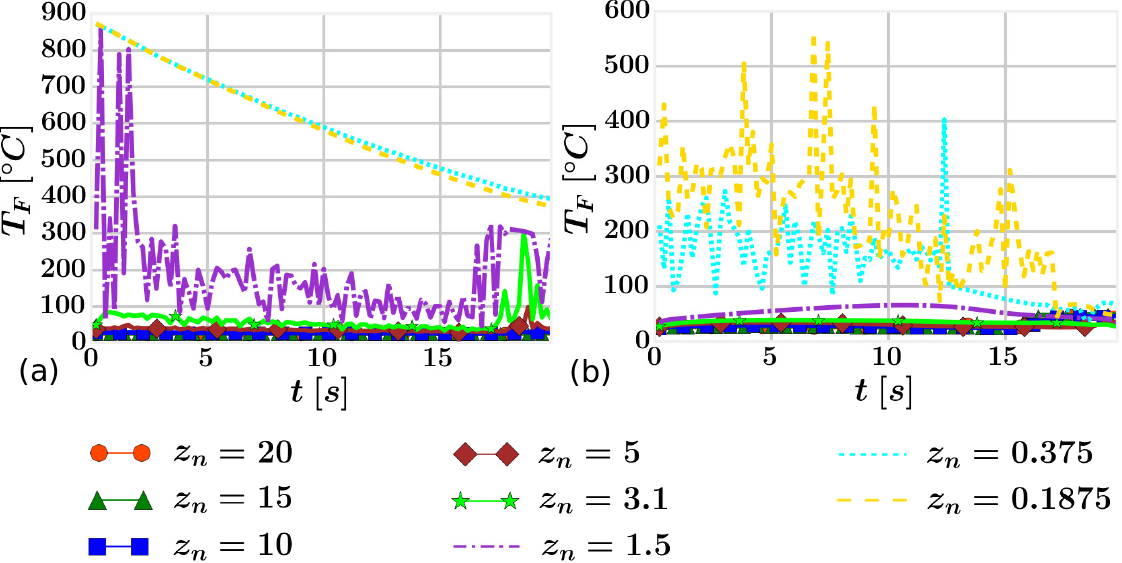
Figure 8. Fluid temperature in the boundary cell according to Equation (37) at the location L 3 using various fluid meshes. ( a ) IPC is not activated; ( b ) IPC is activated.